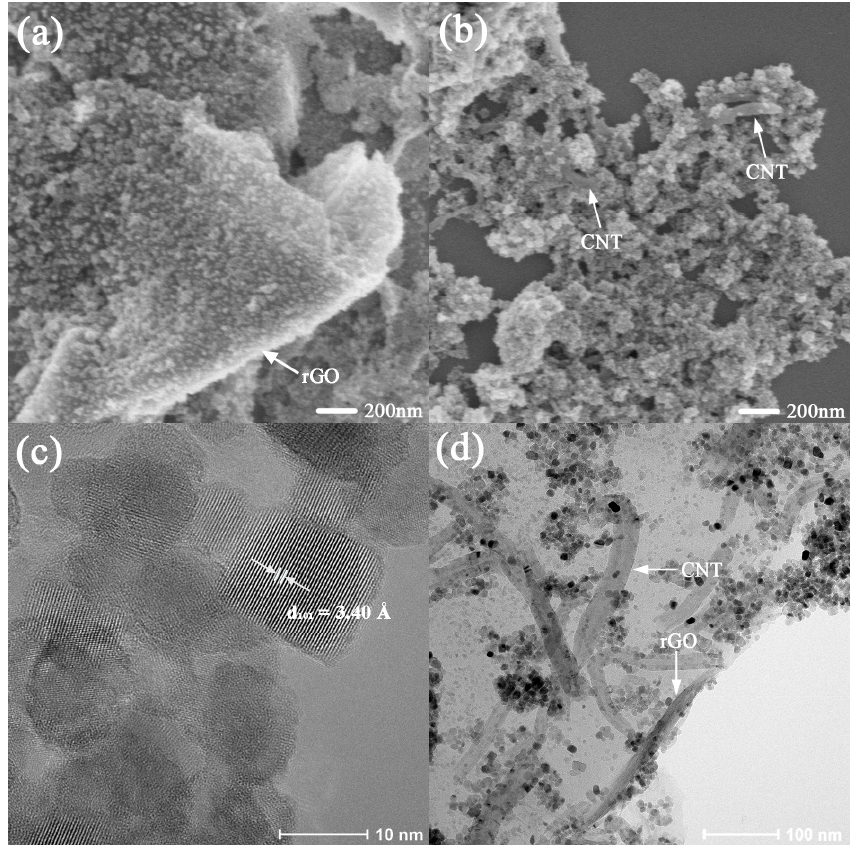
Figure 3. ( a ) Scanning electron microscopy (SEM) image of TiO 2 /rGO; ( b ) SEM image of TiO 2 /CNTs; ( c ) High resolution - transmission electron microscopy (HR-TEM ) of TiO 2 ; ( d ) transmission electron microscopy (TEM) image of TiO 2 /CNTs/rGO-3%. Nanomaterials 2016 , 11 , x FOR PEER REVIEW